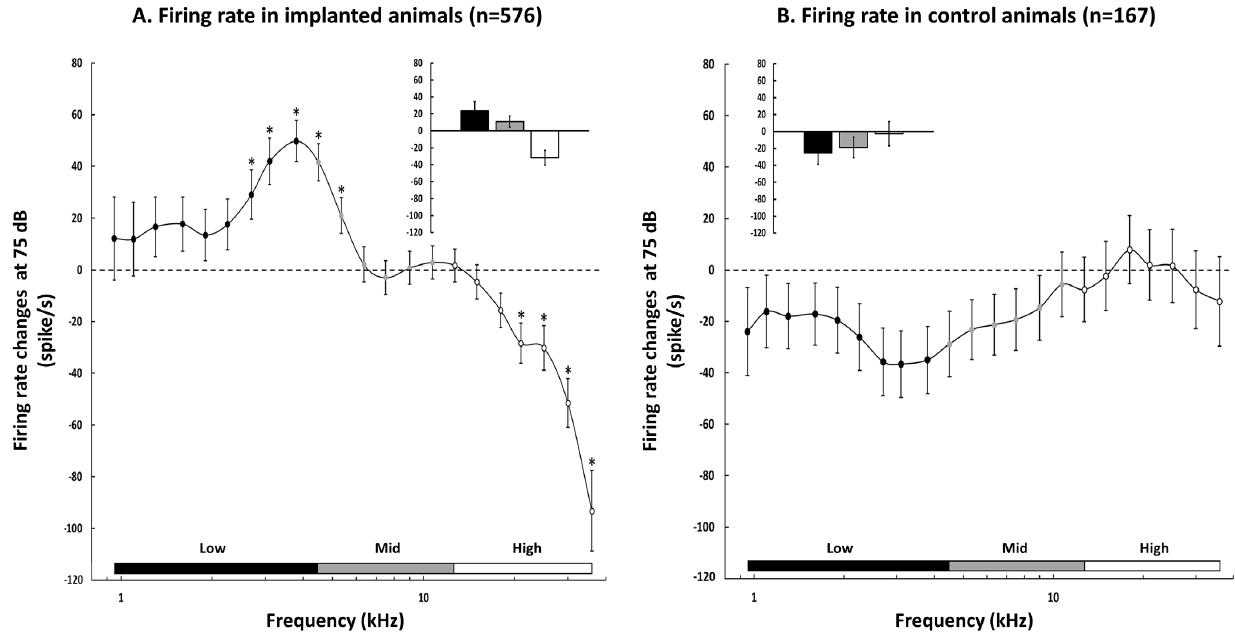
Figure 4. Quantification of the evoked firing rate changes (at 75 dB) in the cochlear-implanted animals ( A ) and in the control animals ( B ). ( A ) At each frequency used to test the Frequency Response Area (FRA), we automatically quantified the evoked responses (at 75 dB) before and after cochlear implant insertion and computed the evoked firing rate change as the difference between the post- and the pre-evoked responses. Negative values indicate decreases in the evoked firing rate and positive values indicate increases in the evoked firing rate. The changes in the evoked firing rate (mean ± sem) are presented for the low frequencies (0.95–3.8 kHz, black dots) and the middle (4.5–10.7 kHz, grey dots) and high (12.7–36 kHz, white dots) frequencies. There were some significant increases in the evoked firing rate at the limit between the low and the middle frequencies (from 2.7 to 5.35 kHz). The evoked firing rates were systematically decreased in the high frequencies; this decrease was significant from 21 to 36 kHz. Asterisks represent significant changes post-insertion compared to pre-insertion (assessed by paired t -tests with p -value < 0.05). The inset shows the mean threshold changes in the low, middle, and high frequencies. ( B ) Same representation as in ( A ). for the recordings obtained from the control animals. The evoked firing rates were derived from a FRA collected at the 1st implantation of the cortical matrix then after the second implantation 30 min later. There was no significant change in the low and middle frequencies (from 2.5 to 3.1 kHz), and also no significant changes in the high frequencies. The inset shows the mean threshold changes in the low, middle, and high frequencies: these changes were significantly different from the CI-implanted animals in the three frequency ranges (see text for details). In A and B, * indicate significant differences between the Pre and Post values of firing rate.